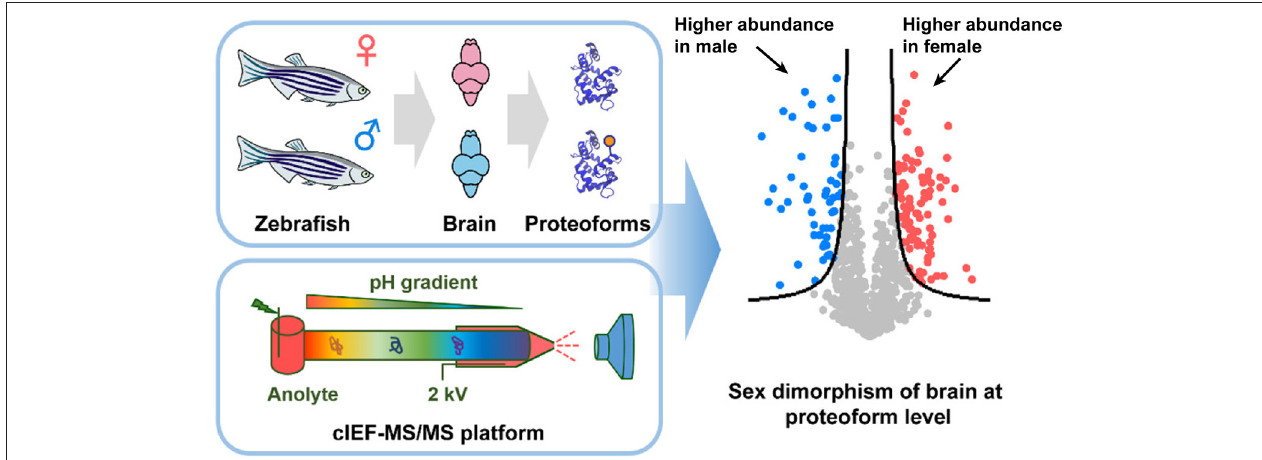
FIGURE 2 | Flow chart of label-free quantitative TDP of female and male zebrafish brains using automated cIEF-MS/MS. Reproduced with permission from Xu et al. (2020) . Copyright 2020 American Chemical Society.